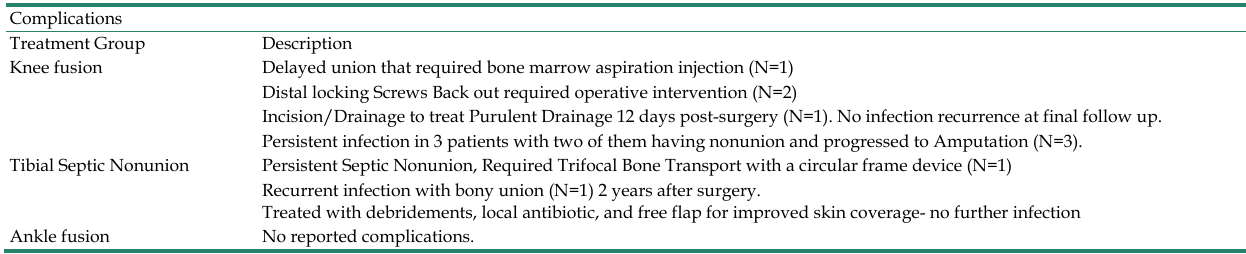
Table 3. Reported complications in our study population Complications Treatment Group Description Knee